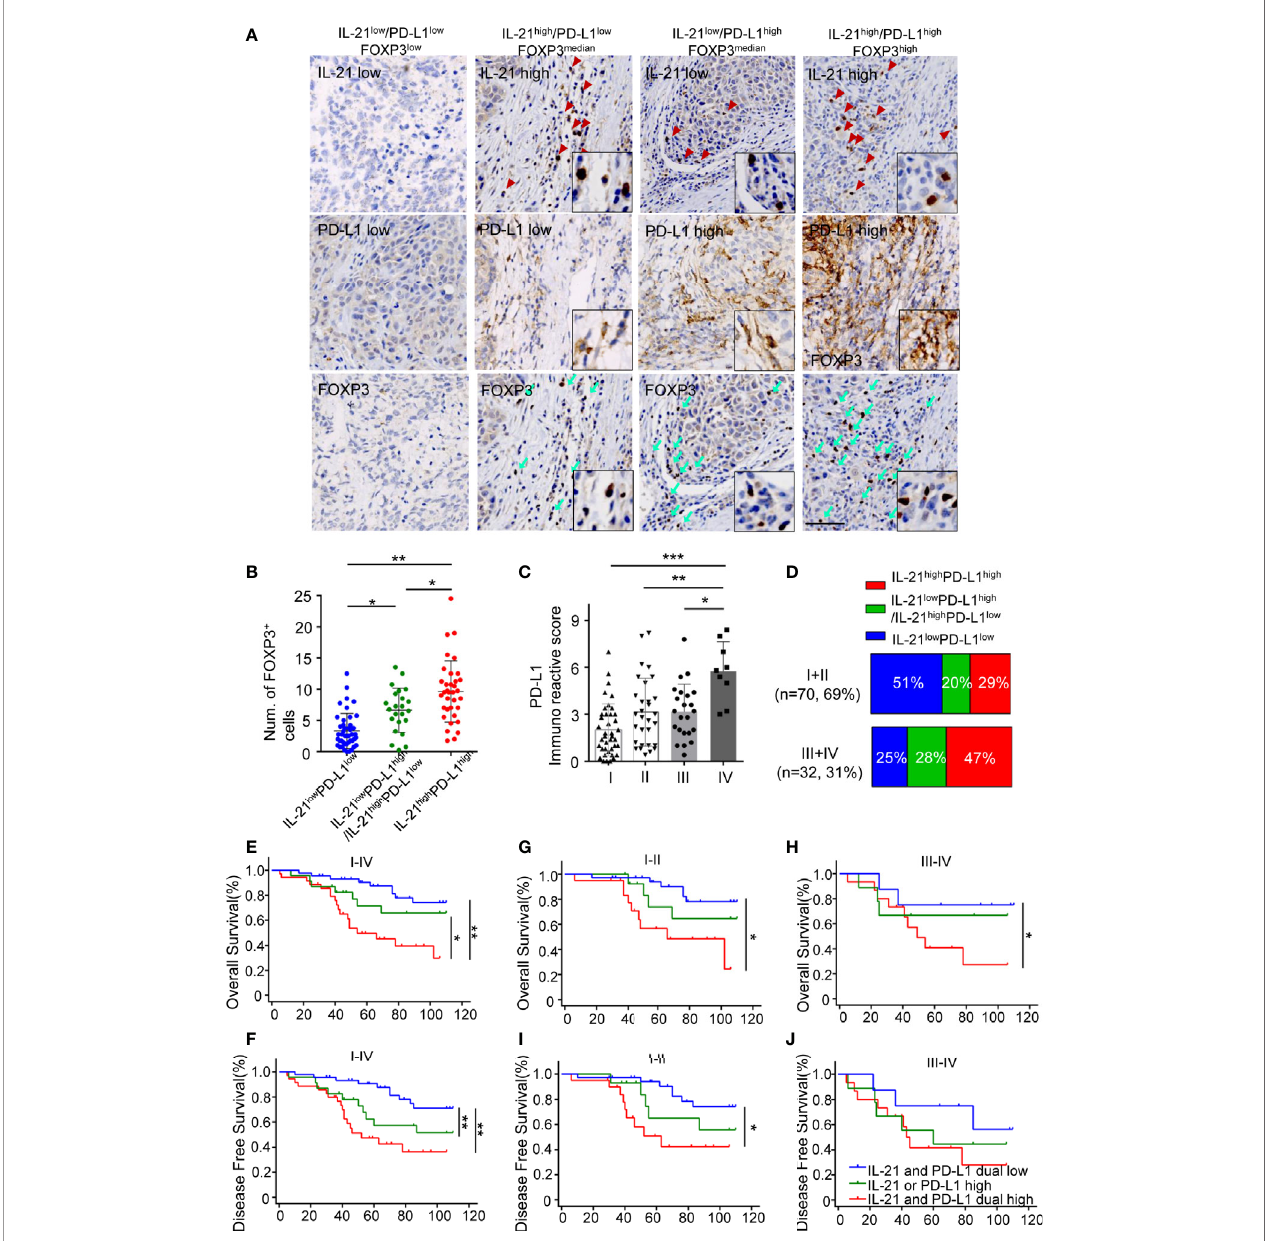
FIGURE 6 | Simultaneous high expression of IL-21 and PD-L1 was associated with more Treg in fi ltrates and worse survival. (A) Representative images of IHC staining showed IL-21, B7-H1 and FOXP3 in serial sections. Scale bar represent 100 m m, magni fi cation, 200×. (B) Quantitative histogram showed that tumors with simultaneous high expression of IL-21 and B7-H1 have more FOXP3 + cells than those with simultaneous low expression of IL-21 and PD-L1 and those with high expression of either IL-21 or PD-L1. (C) B7-H1 expression in tumors with each of the stage I, II, III and IV, *P < 0.05. **P < 0.01, ***P < 0.001, by One way ANOVA (D) Comparison of the percentage of PD-L1 and/or IL-21 expression with stage I and II compared to those with stage III and IV. (E – J) Simultaneous high expression of IL-21 and B7-H1 predicted worse overall and disease-free survival in patients at stages I – IV (E, F) , stages I and II only (G, I) , or stages III and IV only (H, J) with HNSCC. (n (IL-21 and B7-H1 dual low expression) = 44, n (IL-21 or B7-H1 high expression) = 23, n (IL-21 and B7-H1 dual low expression) = 35, *P < 0.05. **P < 0.01). Number at risk and hazard ratio for survival plots has been provides in supplementary table